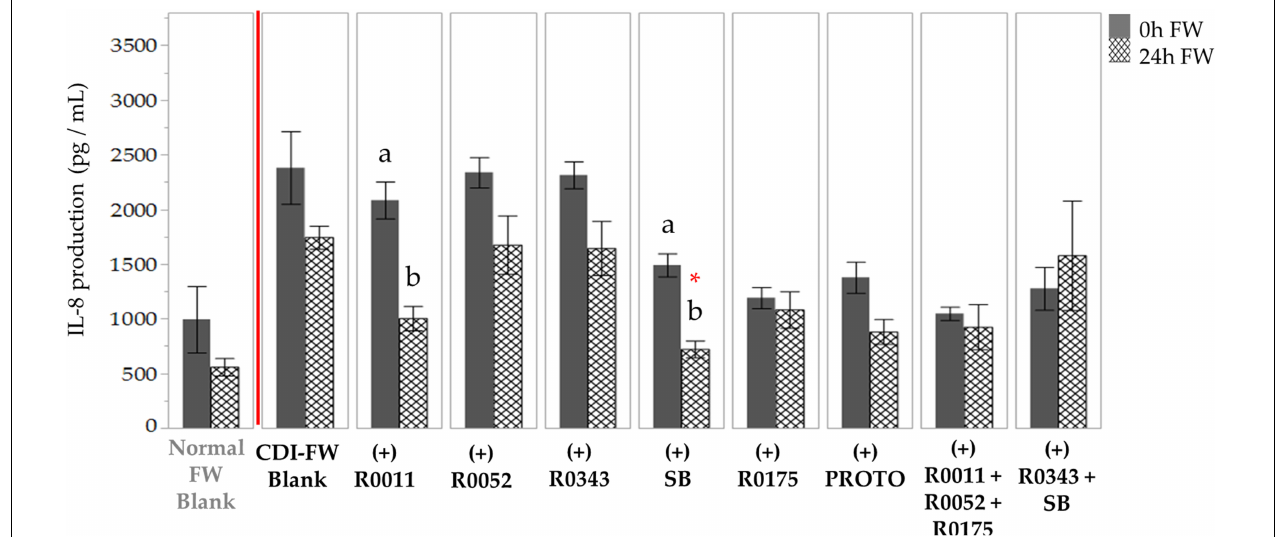
FIGURE 3 | Detection of interleukin-8 production following the exposure of T84 cells to Clostridioides difficile -infected (CDI) fecal water (FW) treatments. , cells treated with FW collected at T = 0 h; , cells treated with FW collected at T = 24 h. Means at time points within treatments not sharing a common letter are significantly different from each other ( p < 0.05). The symbol * represents significant differences ( p < 0.05) between treatment and CDI-FW blank at T = 24 h. R0011 = L. rhamnosus R0011; R0052 = L. helveticus R0052; R0343 = L. rhamnosus GG R0343; SB = S. boulardii CNCM I-1079; R0175 = B. longum R0175; PROTO = ProtecFlorTM; R0011 + R0052 + R0175 = combination of L. rhamnosus R0011, L. helveticus R0052 and B. longum R0175; R0343 + SB = combination of L. rhamnosus GG R0343 and S. boulardii CNCM